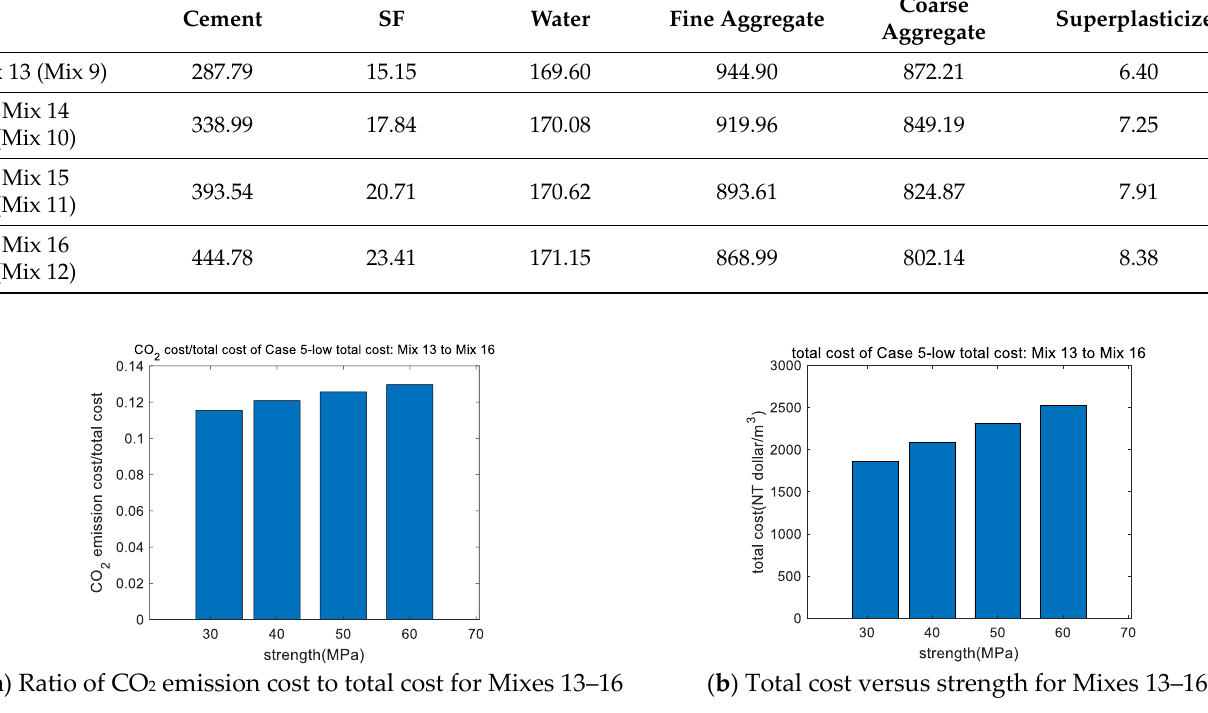
Figure 5. Performance of Case 4: Mixes 13 – 16 (low total cost).